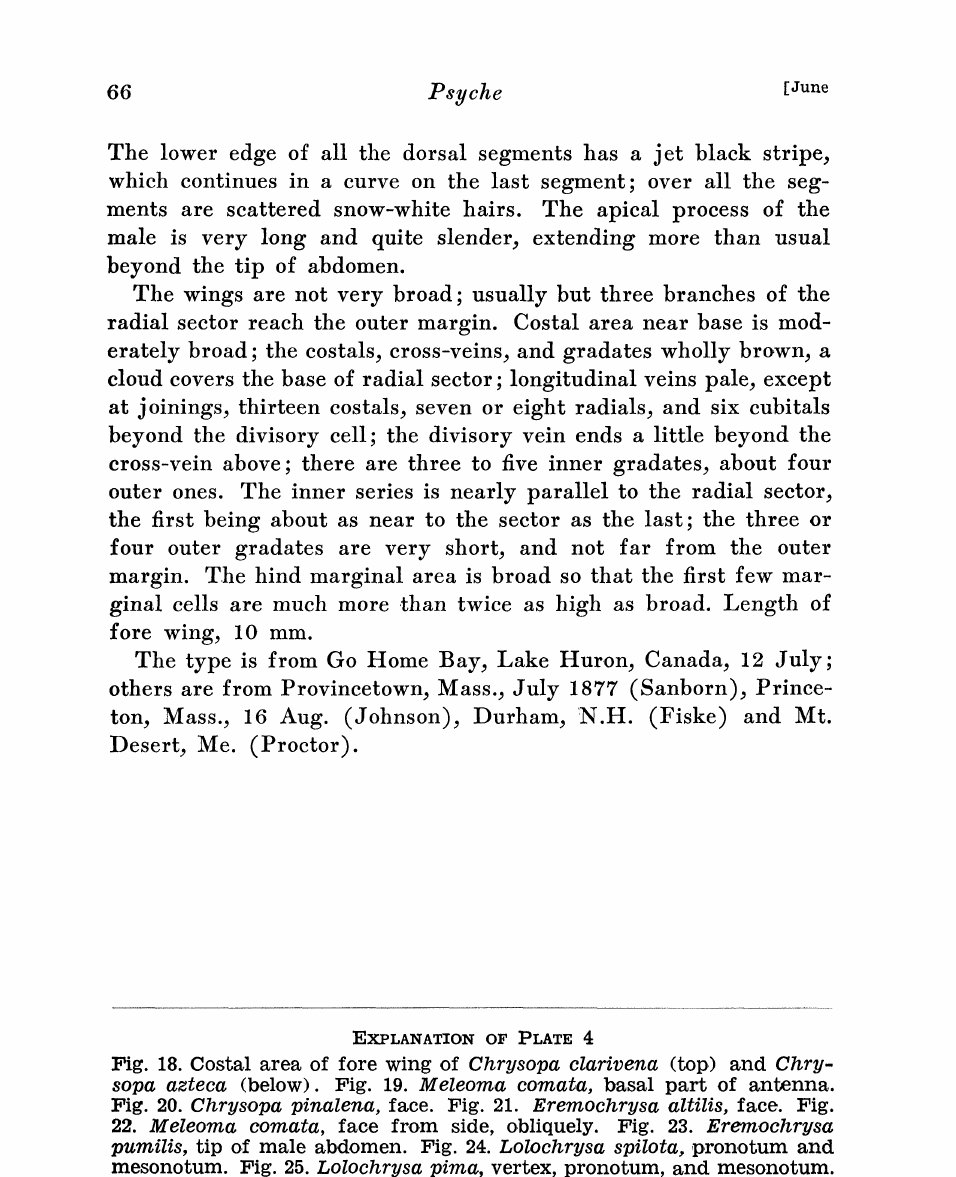
Fig. 18. Costal area of fore wing of Chrysopa clarivena (top) and Chry- sopa azteca (below). Fig. 19. Meleorna corn.at.a, basal part of antenna. lig. 20. Chrysopa pinalena, face. Fig. 21. Eremochrysa altilis, face. Fig. 22. Meleoma comata, face from side, obliquely. Fig. 23. Eremochrysa pumilis, tip o.f male abdomen. Fig. 24. Lotochrysa spiIota, pronotum and mesonotum. Fig. 25. Lolochrysa pima, vertex, pronotum, and mesonotum. Fig. 26. Meleoma cavi]rons, face from side. Fig. 27. Lolochrysa cana- clensis, tip of male abdomen. Fig. 28. Lolochrysa pirna, tip of male ab- domen. Fig. 29. Eremochrysa tibialis, face. Fig. 30. LoIochrysa spilota, tip of female abdomen. Fig. 31. Lolochrysa cali]ornica, tip of male ab- domen (type). Fig. 32. Meleoma delicata, interantennal